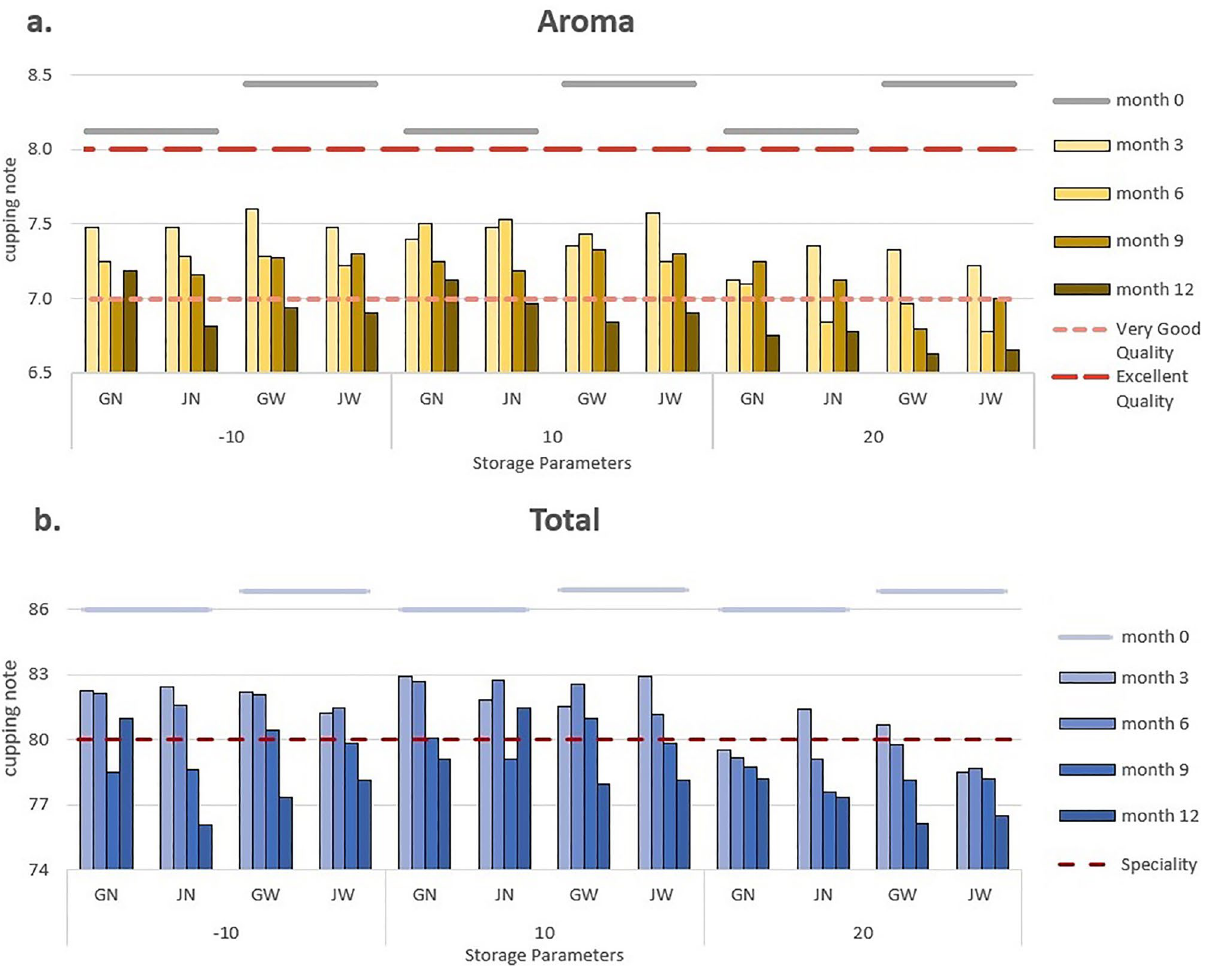
Figure 2. Results of elements of the sensory evaluation for 2( a ) Aroma and 2( b ) Total note in the initial roasted coffee storage in − 10, 10, and 20 °C after storage for 3, 6, 9 and 12